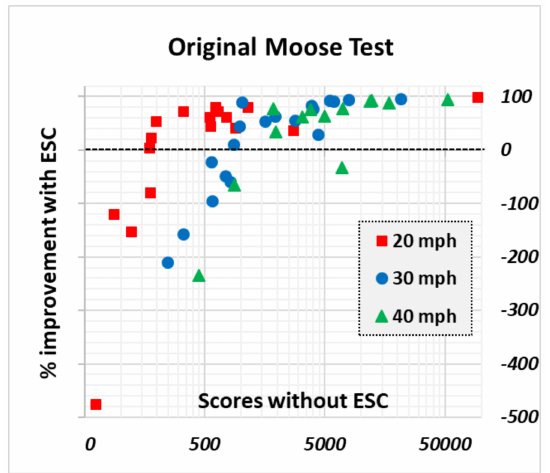
Figure 21. Percent improvement with electronic stability controller (ESC). (original Moose Test).